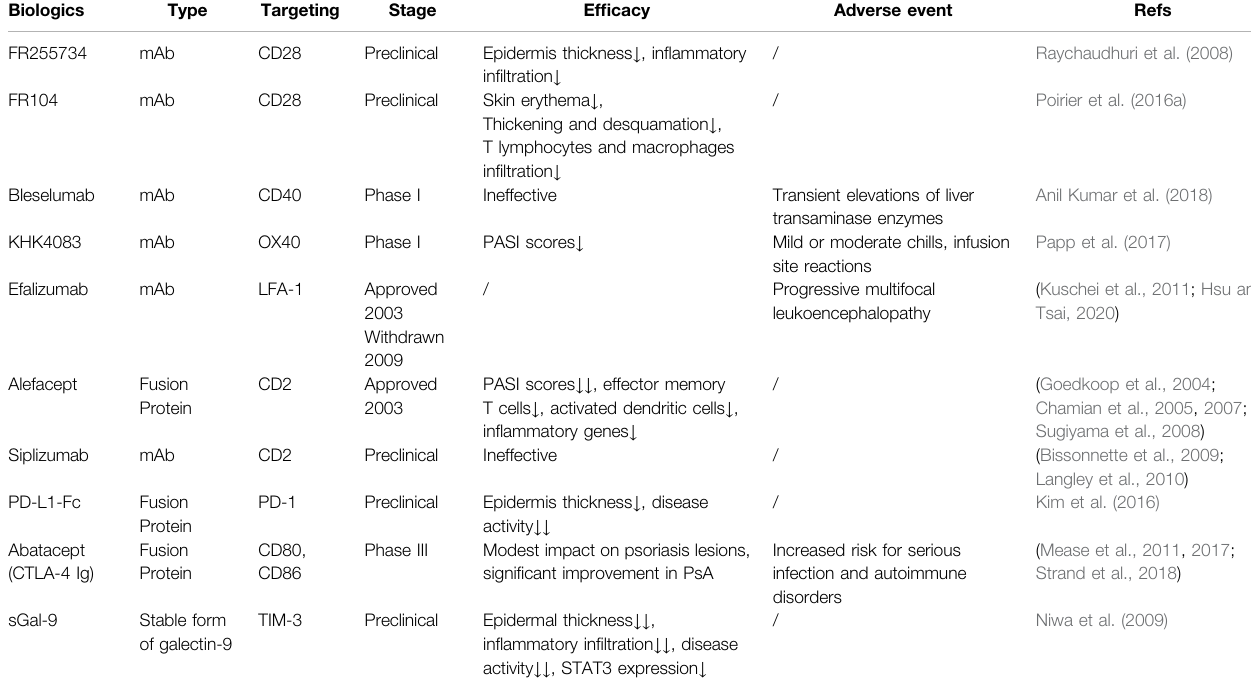
TABLE 1 | Biologic drugs and therapies targeting co-signaling molecules for psoriasis treatment.